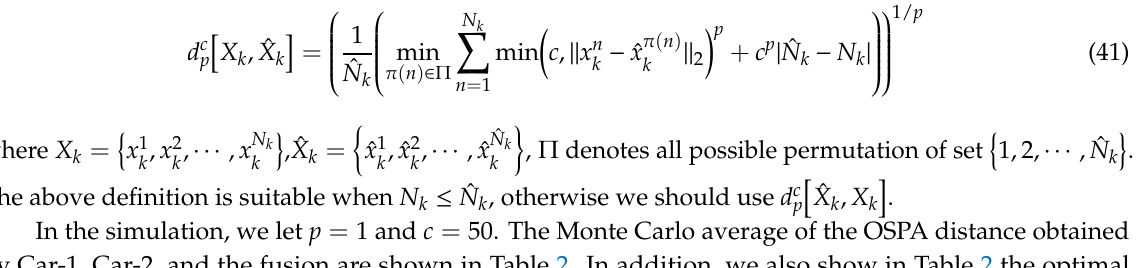
Table 2. Optimal subpattern assignment (OSPA) distance for multi-object tracking (MOT).